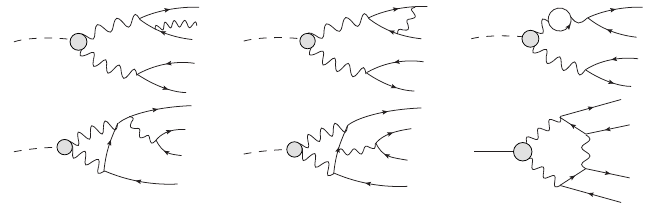
Figure 1. NLO representative diagrams. Upper row: bremsstrahlung, vertex, vacuum polarization. Lower row: three-, four-, and five-point